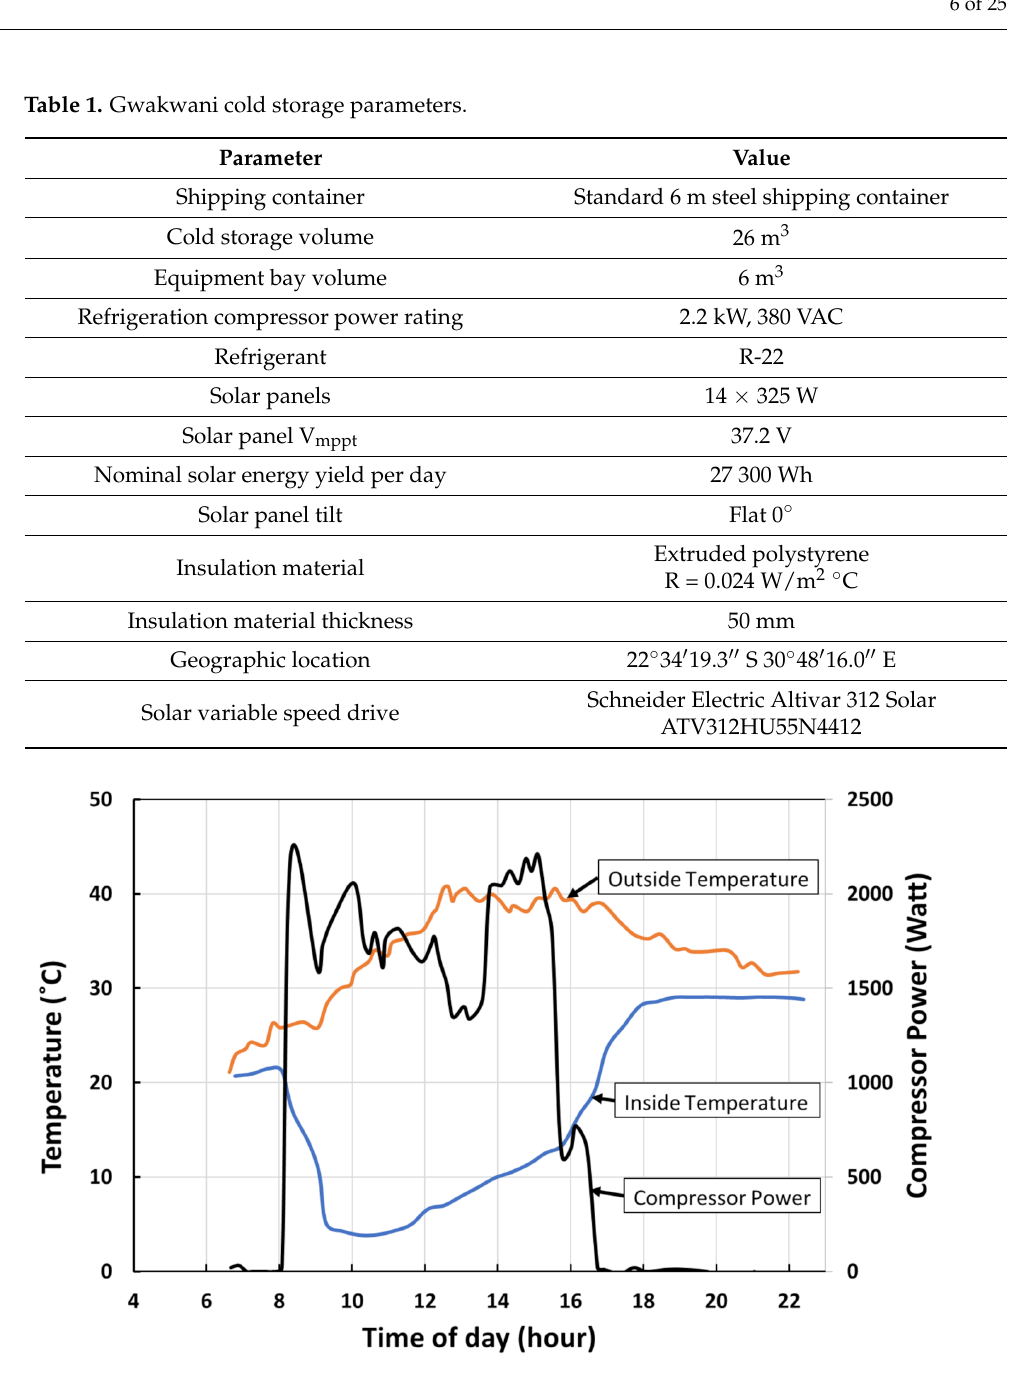
Figure 2. Gwakwani cold storage. Inside temperature, outside temperature, and compressor power consumption as measured on 4 December